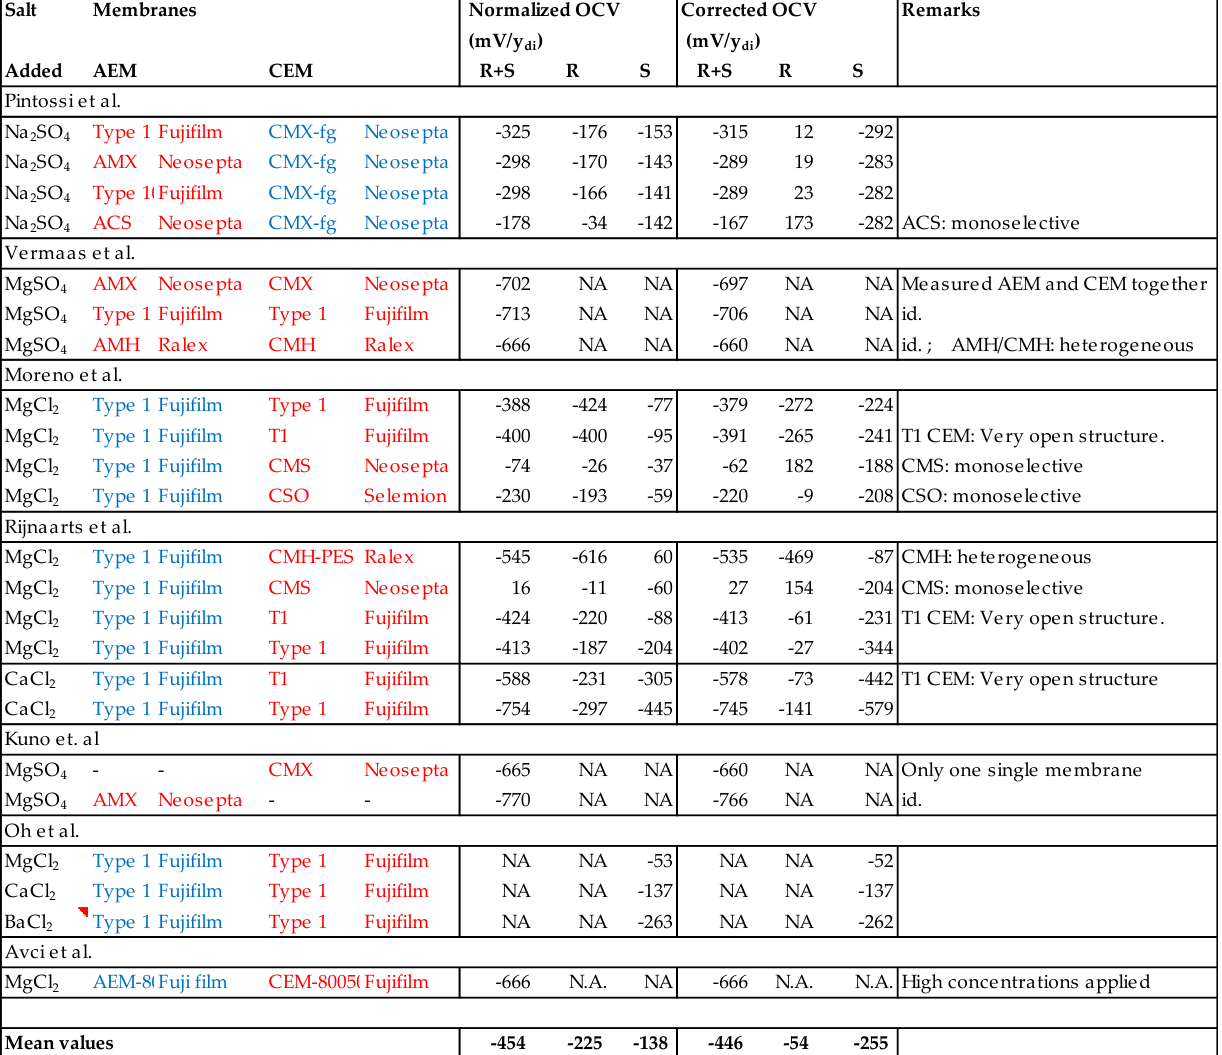
Figure 6. Results of the measured OCV as function of the divalent fraction before (normalized OCV) and after correction. Target membranes are shown in red and other membranes in blue. The slope of normalized and corrected values is given in millivolts per equivalent fraction of the divalent ions (mV/y di ).